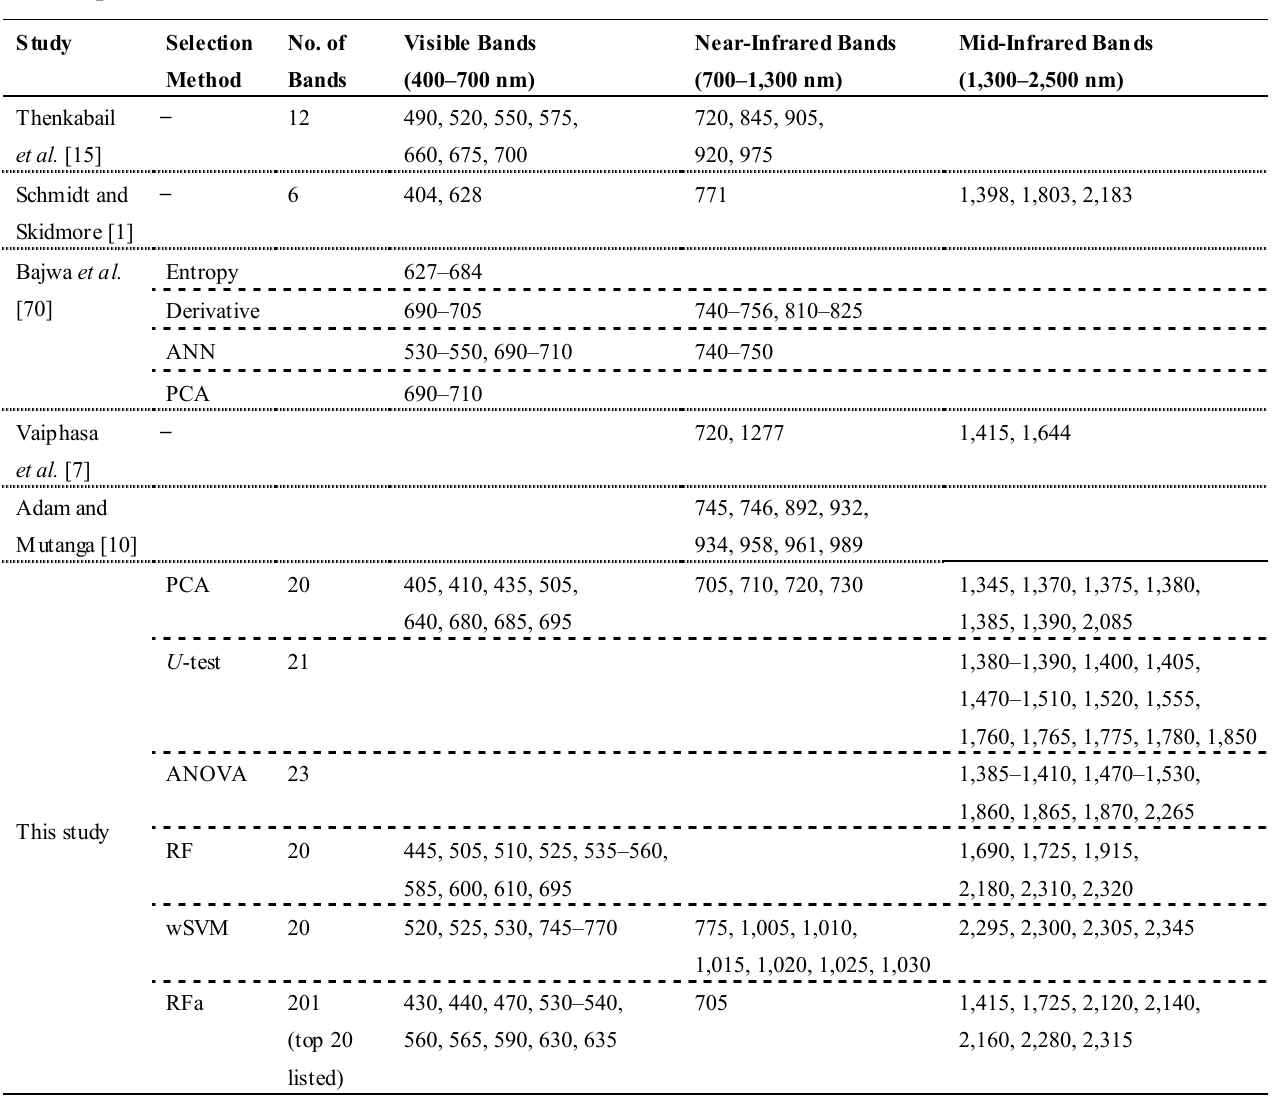
Table 4. Comparison of selected bands between previous studies and this study used for species